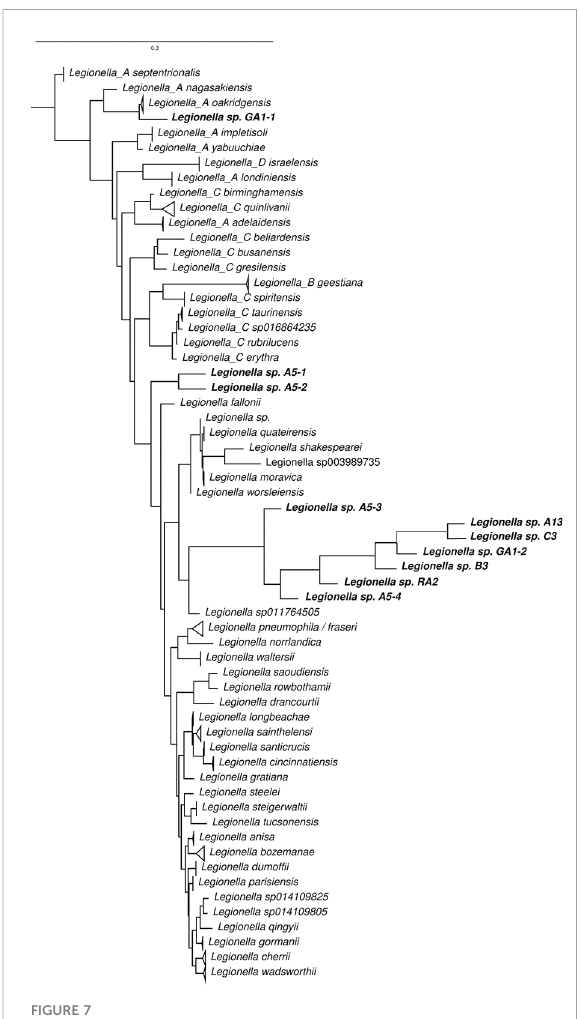
FIGURE 7 Phylogenetic relationship of 16S rRNA gene sequences of species of Legionella and ASVs assigned to L. pneumophila by